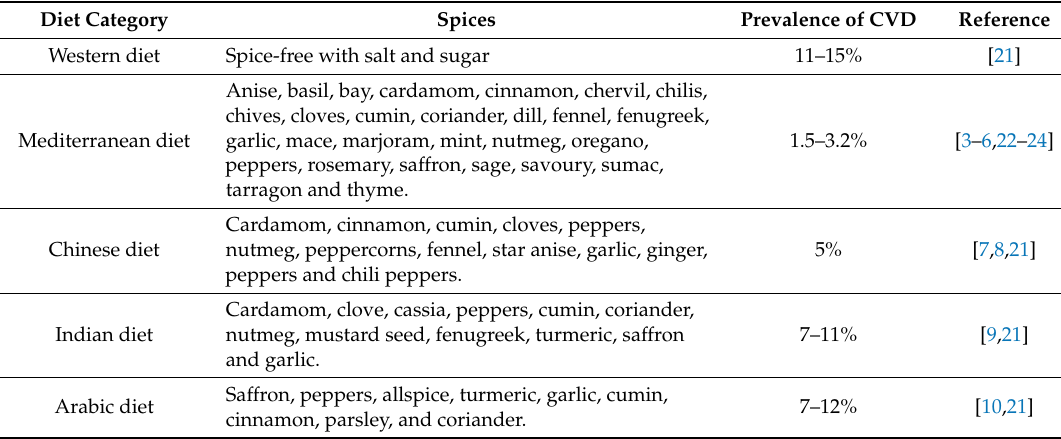
Table 1. Spices in different culture